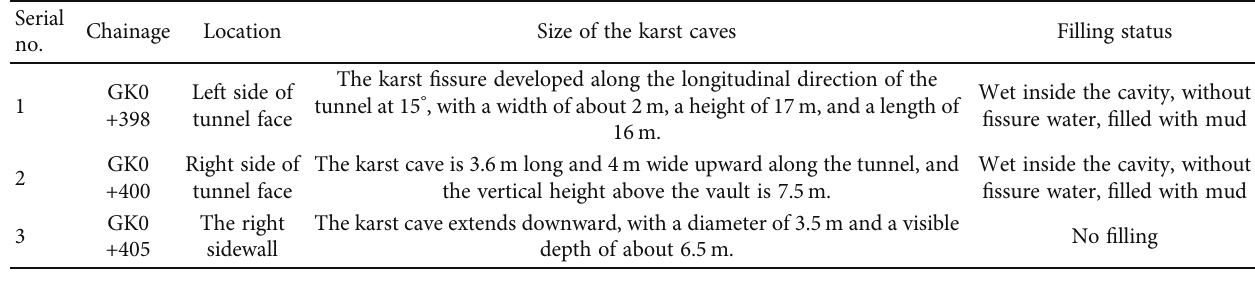
Table 2: Revealed karst caves before mud inrush and